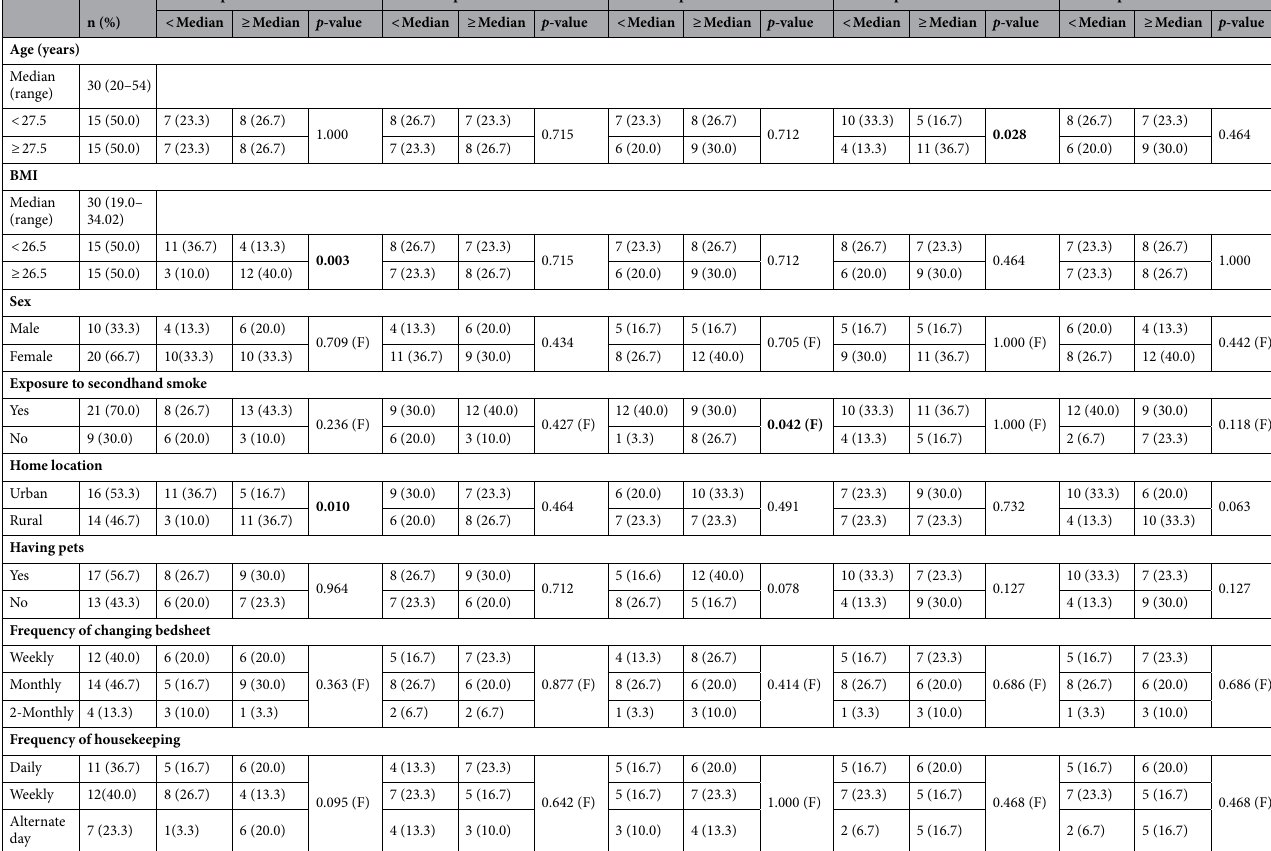
Table 2. Association of OCLN , CLDN3, CLDN, DSG3 and TSLP expression with demographical parameters of AR patients (n = 30). p < 0.05 shown in bold. Abbreviation: AR, allergic rhinitis; OCLN , occludin; CLDN3